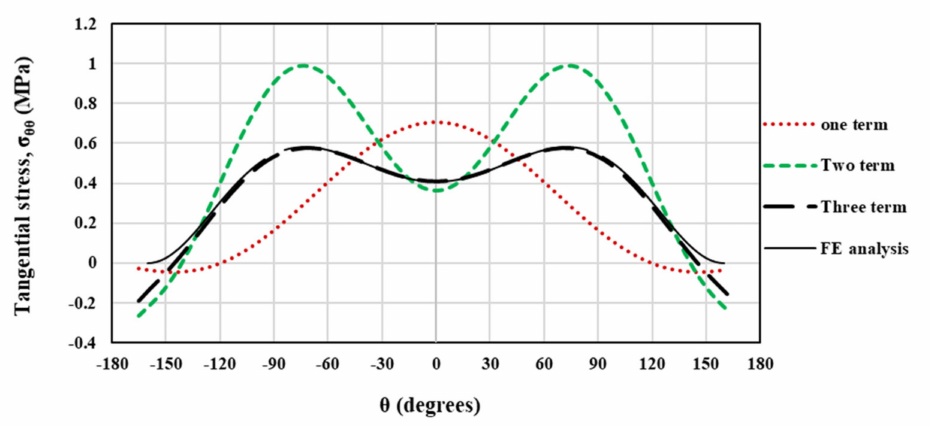
Figure 9. TS distribution provided by FE results and (truncated) theoretical solutions for VO-notched DCB 1 specimen with the root radius of 2.5 mm and opening angle 30 ◦